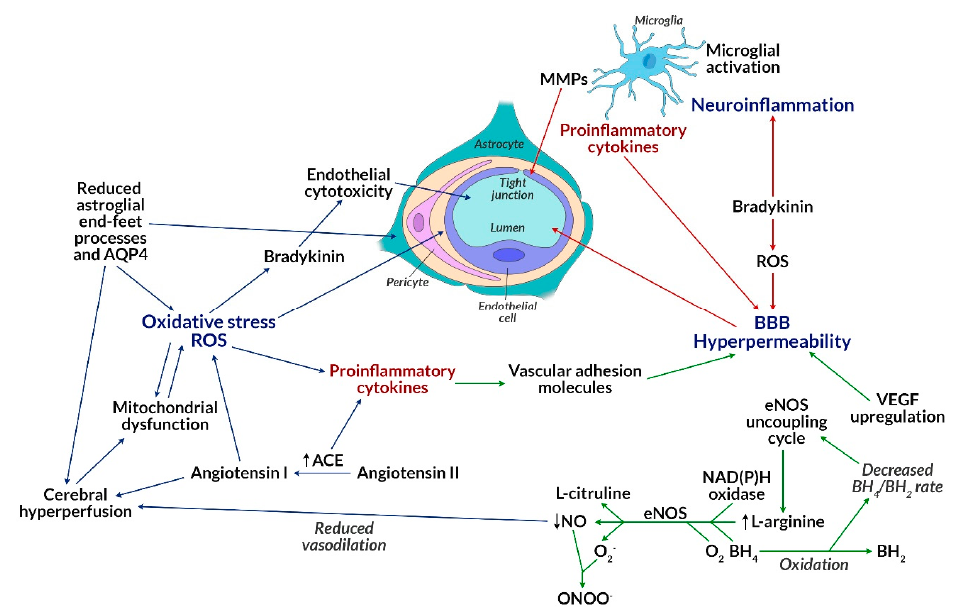
Figure 3. Impact of oxidative stress on blood-brain barrier (BBB) permeability. Excessive ROS, produced among others by mitochondria, may lead to oxidative stress, which may disrupt mitochondrial functions, as well as induce an increase in the level of proinflammatory cytokines. This consequently leads to an increase in the level of VCAM-1 and BBB permeability. Proinflammatory cytokines (formed after the activation of microglial cells) and ROS can also directly a ff ect BBB permeability. The reduced BH 4 / BH 2 ratio activates the eNOS uncoupling cycle, which increases L-arginine levels. Its increased level, as well as participation of NAD(P)H oxidase, BH 4 , O 2 , and eNOS leads to the formation of L-citrulline, NO, and superoxide radical (O 2 •− ). NO reacts with O 2 •− , resulting in highly reactive, harmful peroxynitrite (ONOO − ) forms, whereas the NO levels decrease. NO is responsible for vasodilatation of vessels. A decrease in its level causes a reduction in vasodilatation and, as a consequence, cerebral hyperperfusion. Cerebral hyperperfusion may be the result of reduced astrocyte-foot process and AQP4 levels. Their reduction can also directly lead to oxidative stress. The formation of angiotensin-I from angiotensin-II is catalyzed by ACE, which contributes to cerebral hyperperfusion, as well. Elevated ACE levels may promote the production of proinflammatory cytokines. Bradykinin can be both produced due to reactive oxygen species and lead to their formation. It exhibits a cytotoxic e ff ect on endothelial cells and leads to inflammation of the nervous tissue. Stimulation of VEGF is also associated with an increased BBB permeability. Abbreviations: ACE: Angiotensin-converting